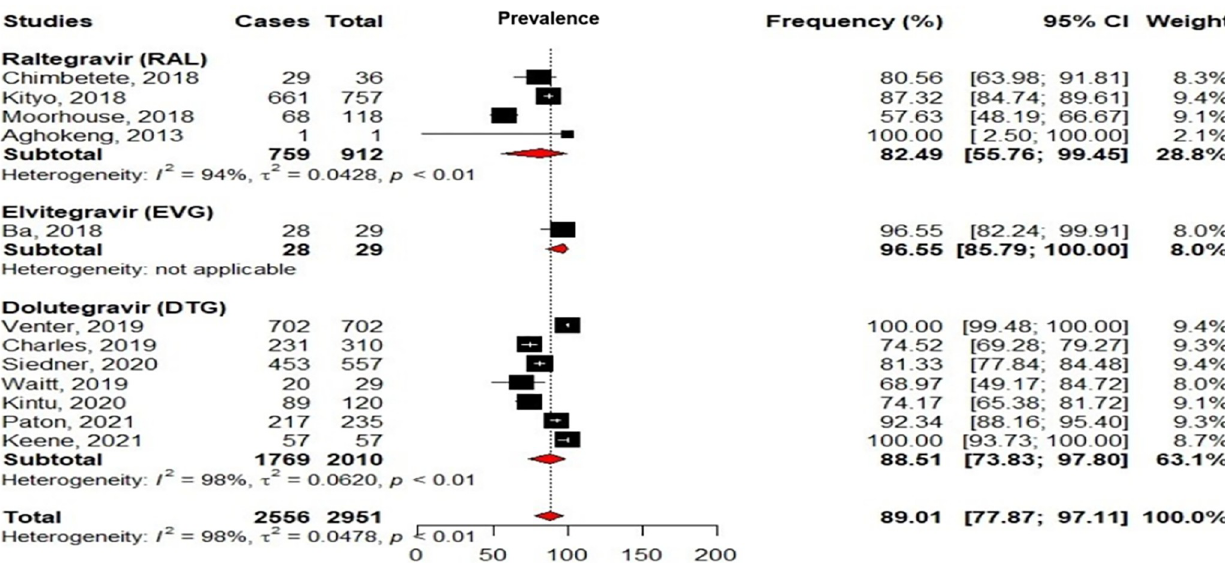
Fig 5. The plot was constructed with R v3.6.0 software, with the use of “meta” and “metaphor” packages. Weights are all from random effects analyses and represent the degree of confidence of each study compared to all other studies in the meta-analysis. Squares represent the rate of virological control in each study, with plain lines representing 95%CI in those studies. Diamonds represent pooled estimates within subgroups, with the value being at the center while extremities play the role of 95%CI. The interrupted line represents the median value after aggregation of all the data while the 0–120 scale represents the range of possible data in the